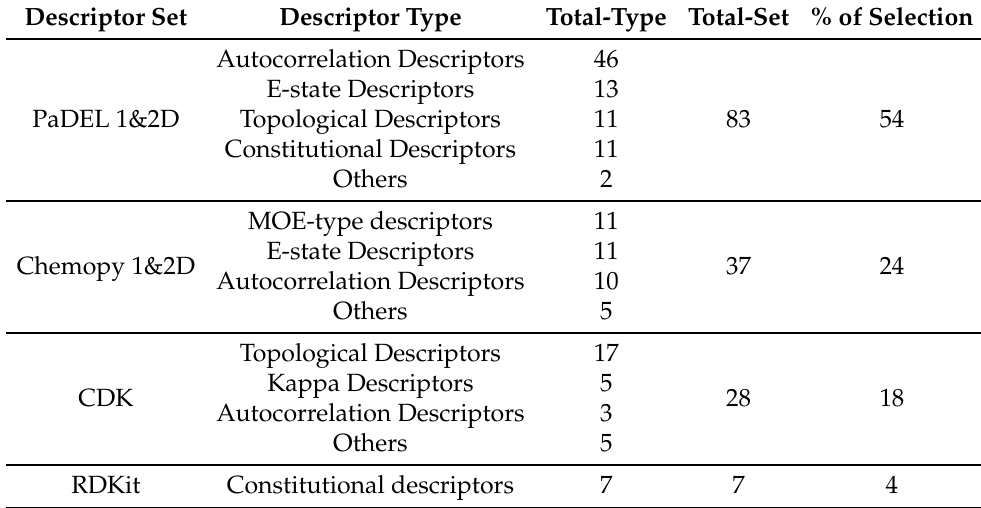
Table 4. Details of the selected optimal descriptor